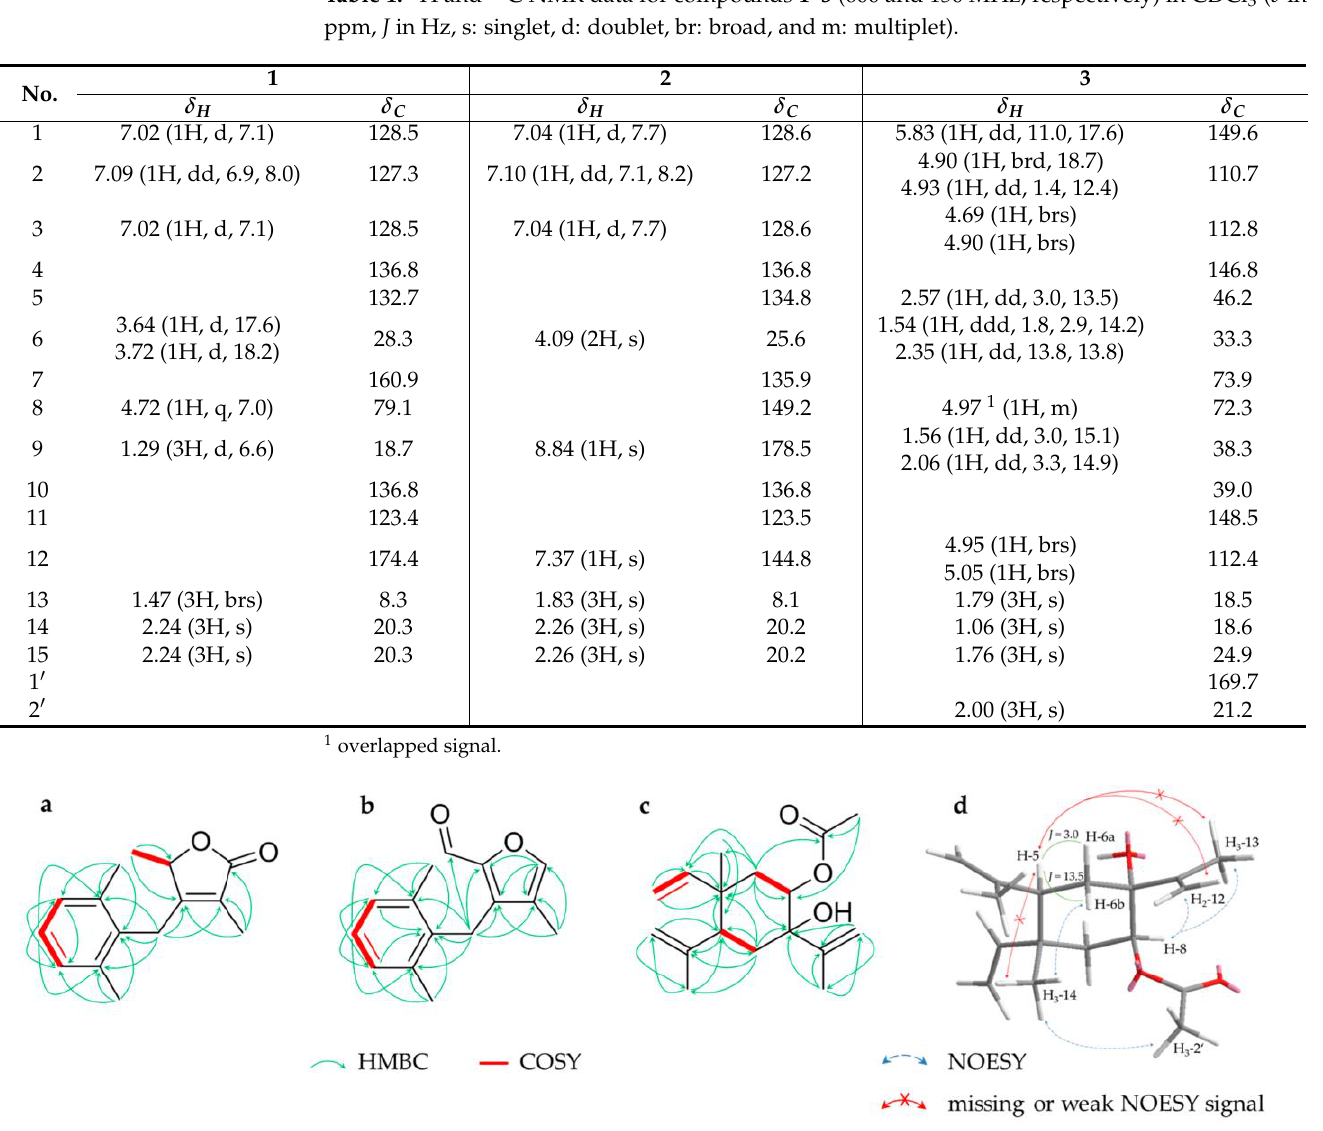
Table 1. 1 H and 13 C NMR data for compounds 1 – 3 (600 and 150 MHz, respectively) in CDCl 3 ( δ in ppm, J in Hz, s: singlet, d: doublet, br: broad, and m: multiplet).